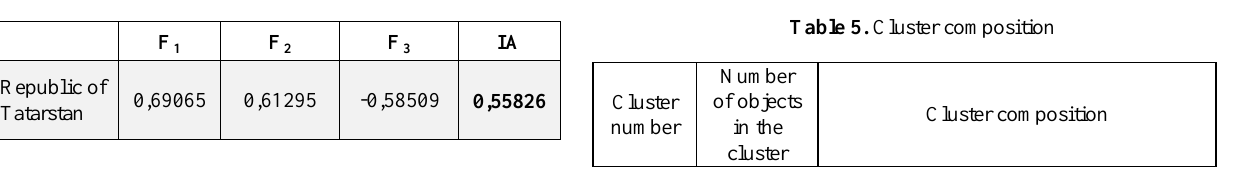
Table 4. Integrated assessment of investment